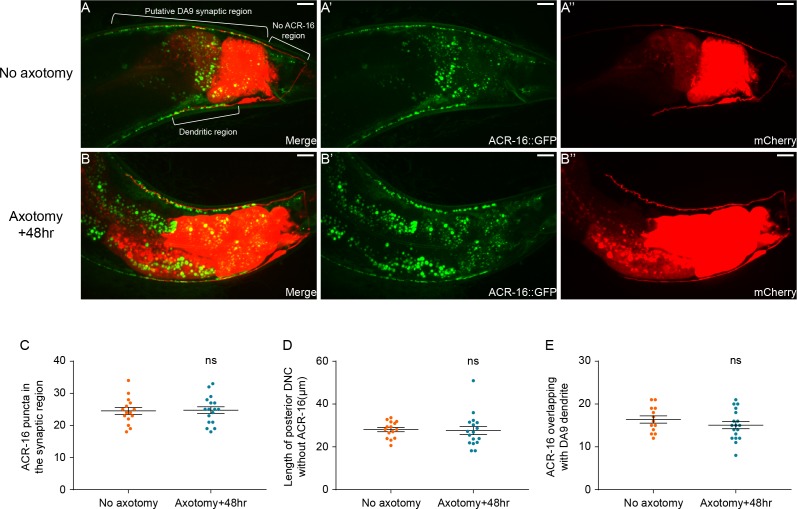
No change of postsynaptic receptors in body wall muscles after axotomy.(A–A’’) Muscle ACR-16 localization in intact animals. Note its localization in both the dorsal and ventral nerve cords. Scale bars = 10 μm. (B–B’’) Muscle ACR-16 maintains its localization 48 hr after DA9 axotomy. Scale bars = 10 μm. (C) ACR-16::GFP puncta number in the putative DA9 synaptic region (~85 μm anterior from the most posterior ACR-16 puncta in the dorsal nerve cord) in both intact and axotomized animals. ns, not significant. Unpaired t test. (D) Length of posterior DA9 axon without ACR-16 in both intact and axotomized animals. ns, not significant. Unpaired t test. (E) Number of ACR-16::GFP puncta overlapping with DA9 dendrite in both intact and axotomized animals. ns, not significant. Unpaired t test.